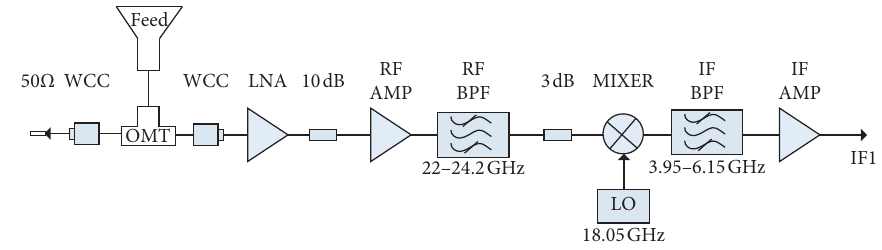
Figure 6: Structure of the K-band ambient receiver.